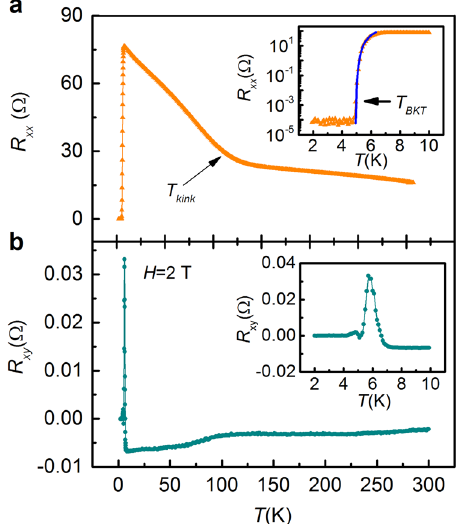
Fig. 3 Electrical transport measurements. a Temperature depen- dence of the resistance R xx from 1.9 to 300 K. b Temperature dependence of Hall resistance R xy at a magnetic fi eld of 2 T. The insets are the corresponding magni fi ed fi gures around T c and the blue solid line is the fi tting result by BKT-like transition plane con fi gurations, determined using the criterions of 90% and 0.1% normal-state resistance (see Supplementary Fig. S4 for the detailed information). 34,35 The upper critical fi eld vs. temperature curves can be well fi tted by: 36 ð 2 Þ where H c2 (0) is the upper critical fi eld at absolute zero temperature. The extrapolated values of H c2 are about 13.6 and 13.7 T for magnetic fi elds perpendicular ( H ⊥ (111)) and parallel ( H // (111)) to the TiO fi lm surface, respectively. Correspondingly, the Landau – Ginzburg superconducting coherence lengths, ξ = [( h/2e )/ (2 π H c2 )] 1/2 , at absolute zero temperature are estimated to be about 4.92 and 4.91 nm for H ⊥ (111) and H //(111), respectively. According to the anisotropic effective mass Ginzburg-Landau theory, 37 the anisotropy ratio ε ~ 1.01 was obtained from the scaling law ε ¼ ð m = m Þ 0 : 5 ¼ H == = H ? . Here H ? and H == are the upper critical ? == c 2 c 2 c 2 c 2 fi elds for H ⊥ (111) and H //(111), and m ? and m == are the effective masses of electrons along these directions, respectively. As for the temperature dependence of H irr , it can be well fi tted by: 36 ð 3 Þ